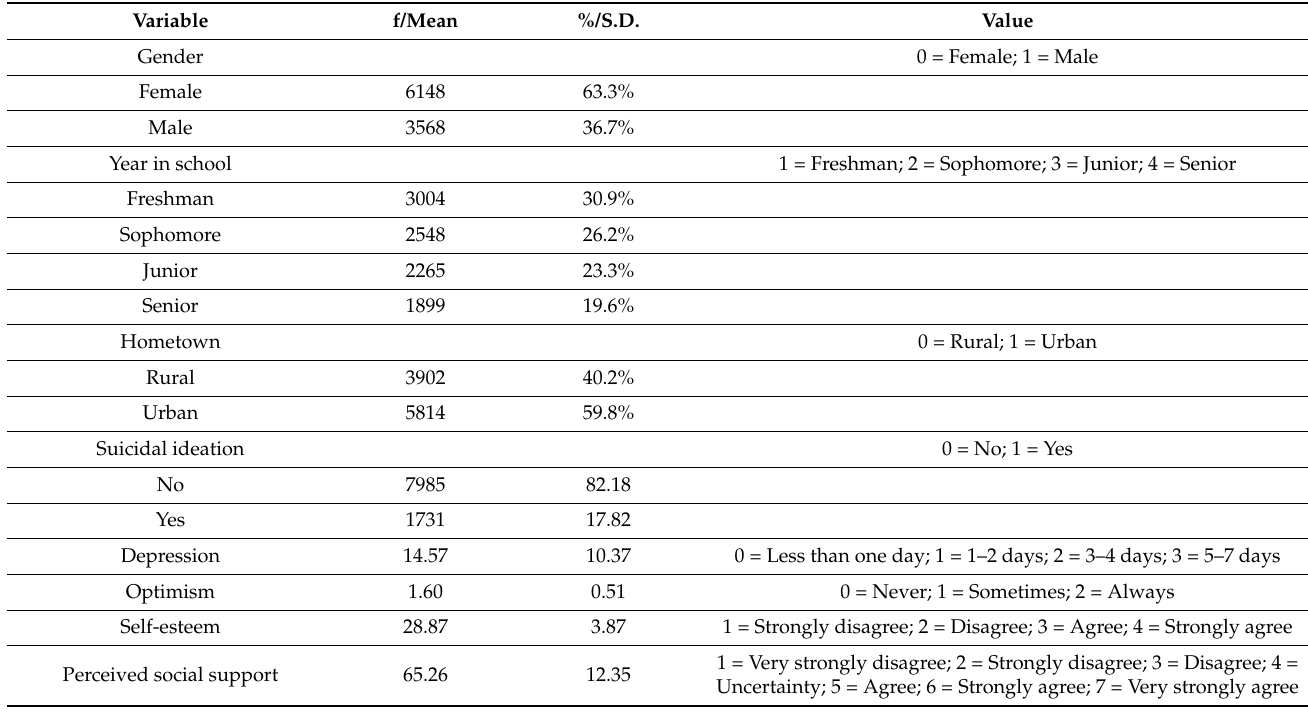
Table 1. Variable Descriptive Statistics (N =